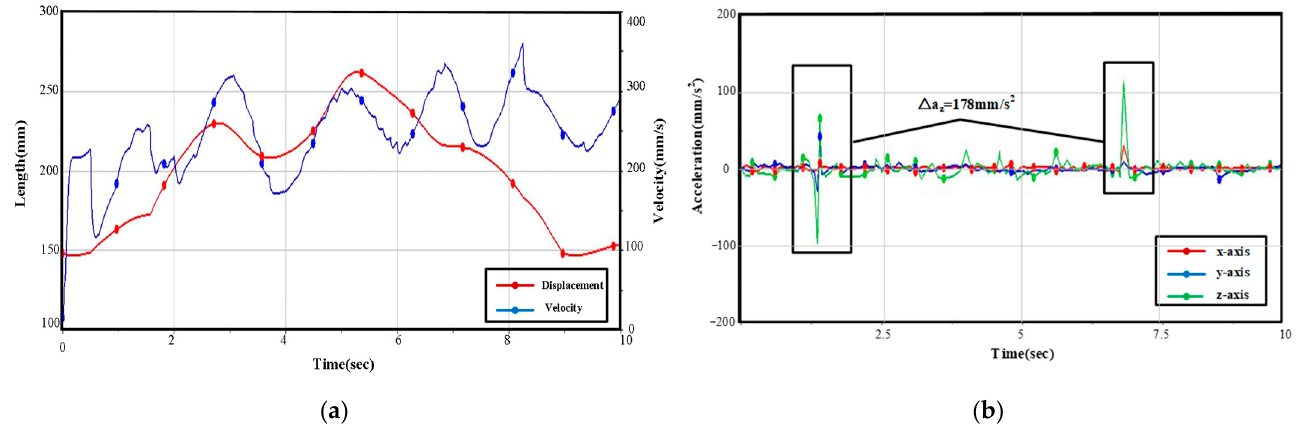
Figure 19. Simulation result of crossing a complex road surface. ( a ) Robot centroid displacement and velocity; ( b ) robot centroid acceleration.